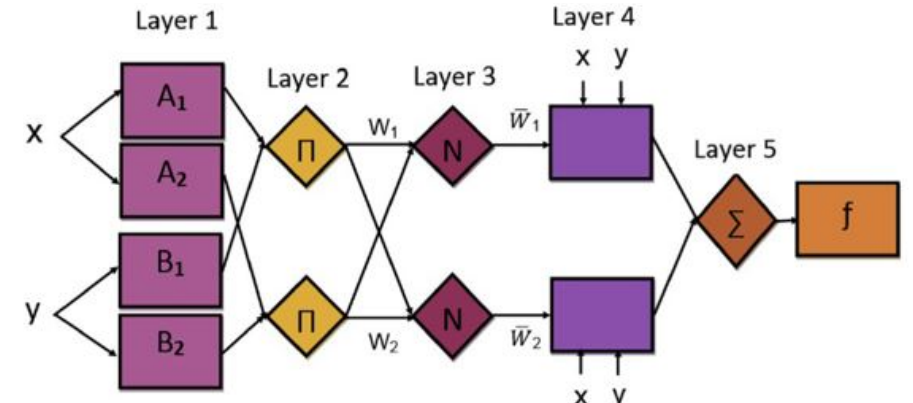
Fig. 3: First order type Sugeno FIS and ANFIS Structure Model